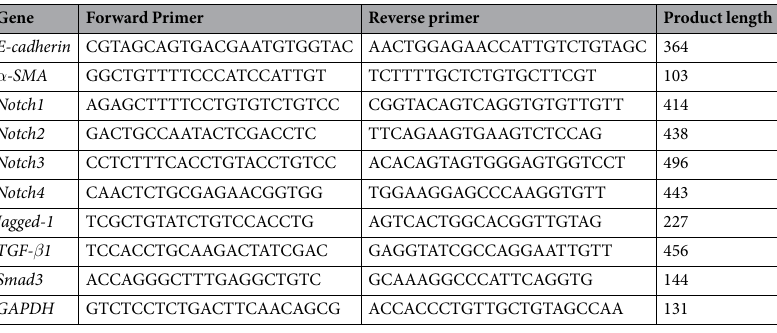
Table 1. Primers sequence of reverse transcription-PCR analysis for